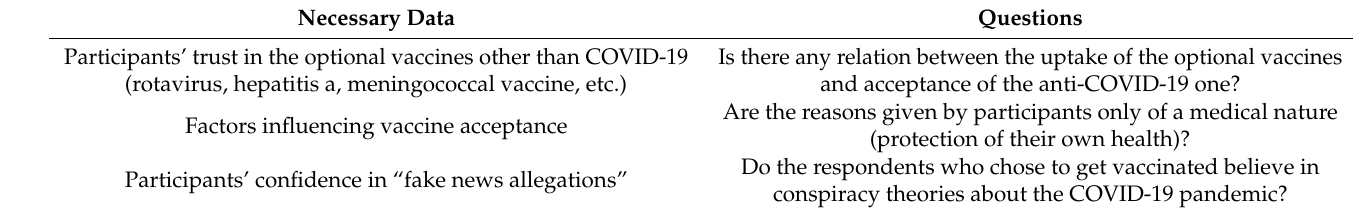
Table 1. Necessary data and